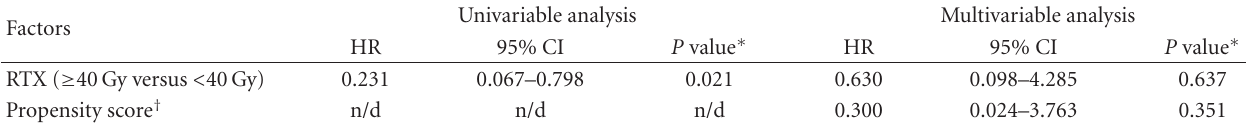
Table 4: Univariable and multivariable analysis for the e ff ect of radiotherapy on